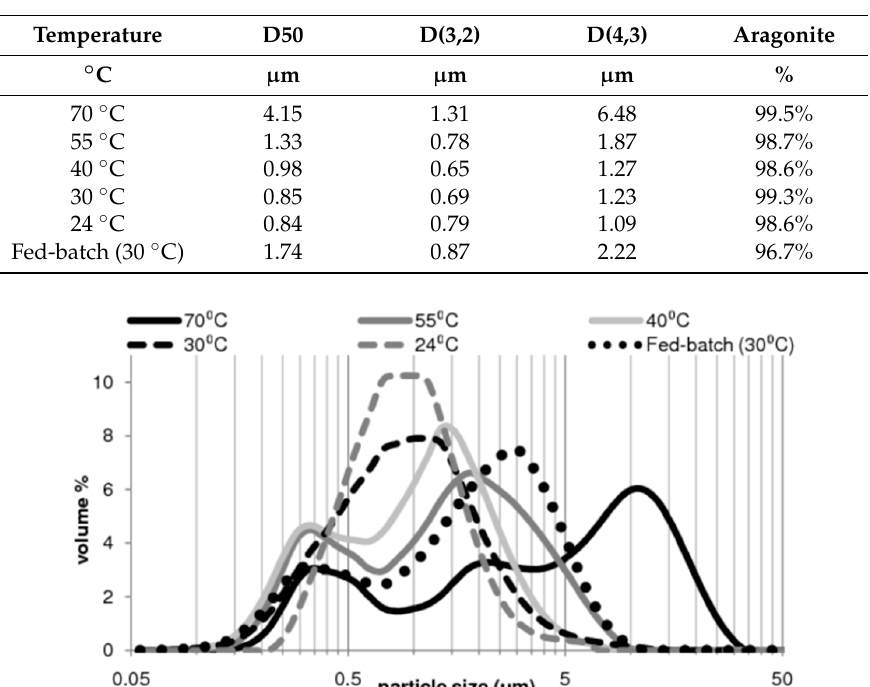
Table 2. Average particle sizes of pure aragonite synthesized with ultrasound at different temperatures [23]. Re-used with permission from Elsevier (4366260353846).